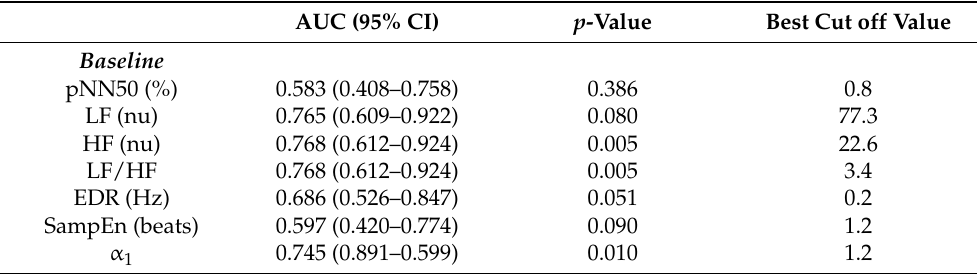
Table 4. ROC curve analysis of heart rate response ( ∆ HR) and heart rate variability